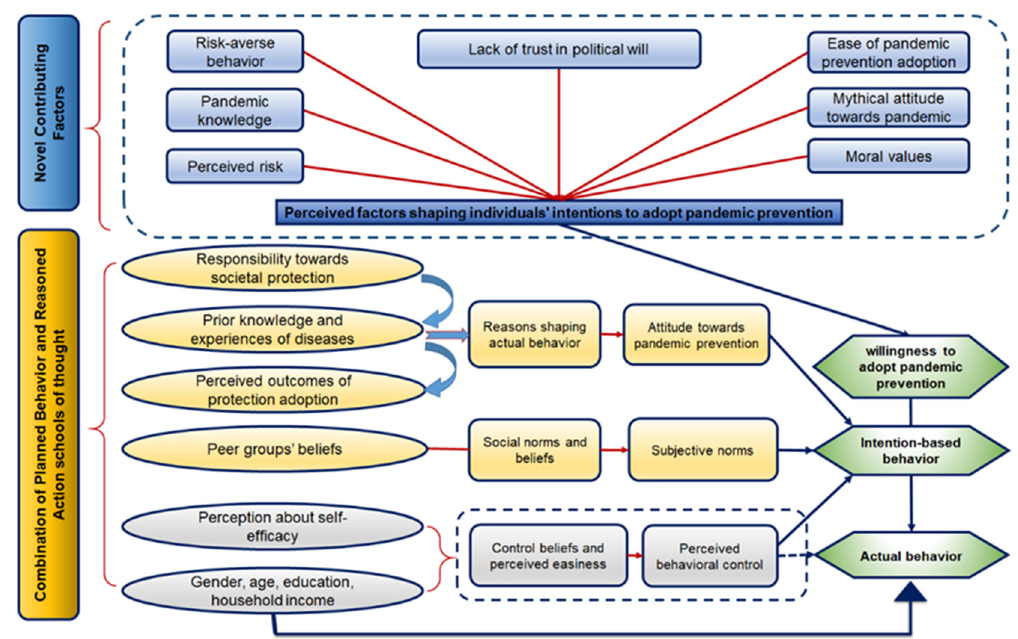
Figure 1. Modifications to the planned behavior and reasoned action schools of thought for novel contributing factors affecting individuals’ willingness to adopt pandemic prevention. Source : Authors’ drawing.